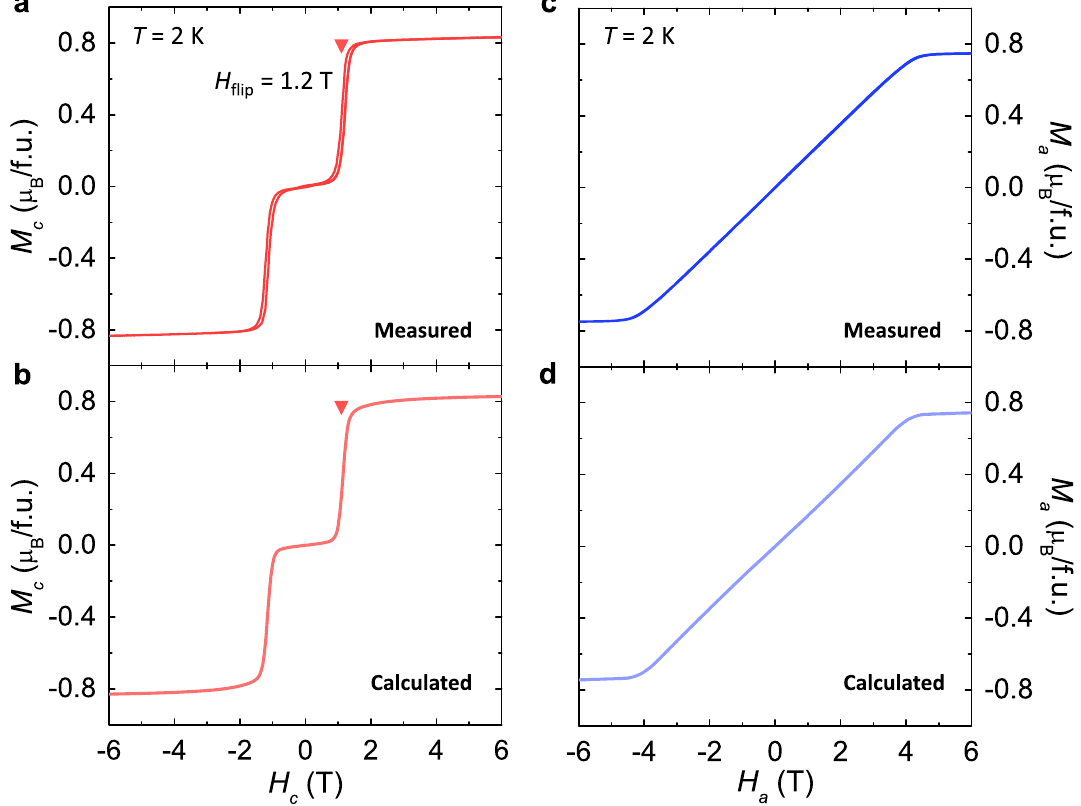
Figure 2. Measured and calculated isothermal magnetizations. ( a ) H -dependence of magnetization ( M ) for H//c ( M c ), measured at T = 2 K. The red inverted triangle denotes the occurrence of the spin-flip transition, H flip = 1.2 T. ( b ) H -dependence of M c , calculated from the easy-axis anisotropic model. Parameters obtained by fitting are given by g µ B H flip / JS = 2 , where S is the saturation magnetic moment, and K = 1.4 JS 2 . ( c ) H -dependence of magnetization ( M ) for H//a ( M a ), measured at T = 2 K. ( d ) Calculated H -dependence of M a